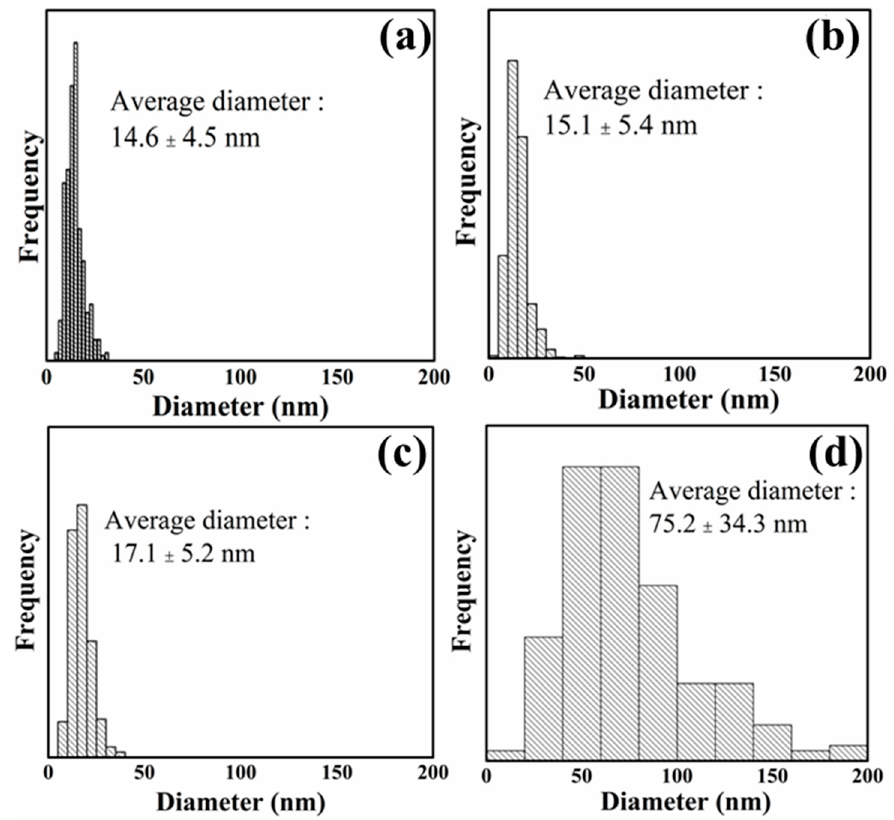
Figure 2. Diameter distribution of PCNF ( a ), LCNF5 ( b ), LCNF19 ( c ), and LCNF30 ( d ).